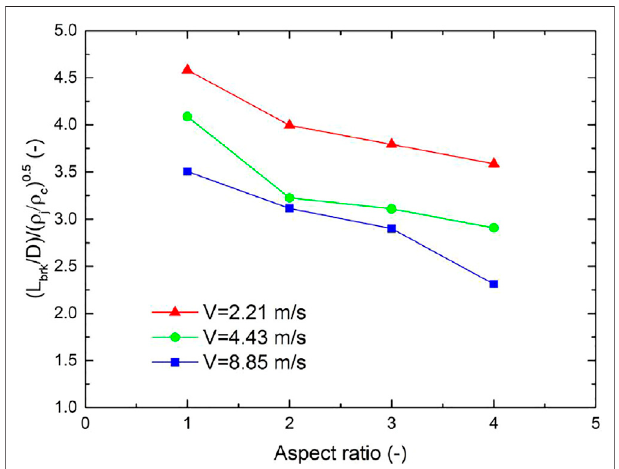
FIGURE 5 | Dimensionless jet breakup length vs. aspect ratio in the 12 cases.